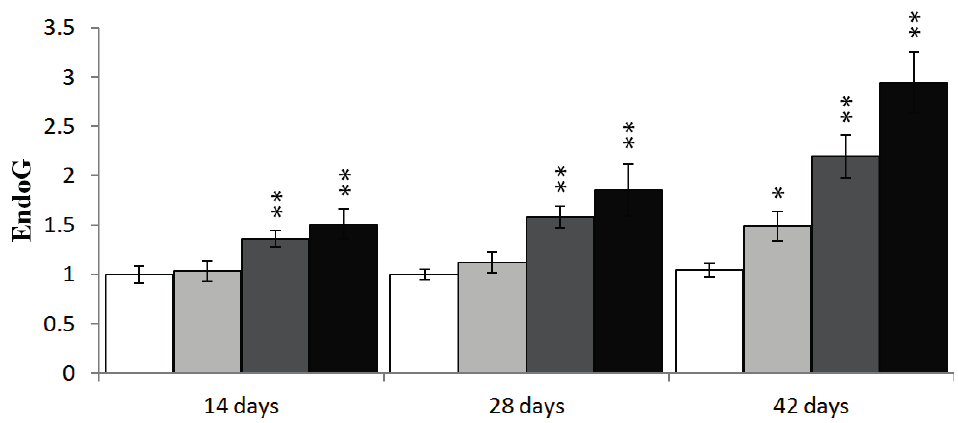
Figure 8. The mRNA expression levels of AIF and EndoG in the kidney. Data are presented with the mean ± standard deviation ( n = 5); * p < 0.05, compared with the control group; ** p < 0.01, compared with the control